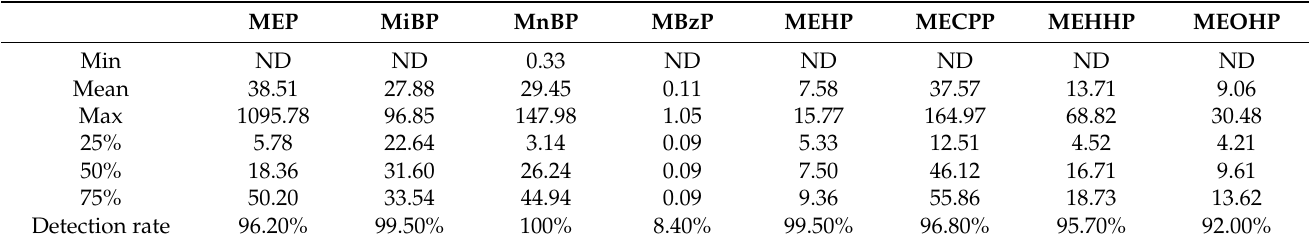
Table 2. Distribution of phthalate metabolite concentrations ( µ g/L) in urine samples for 294 children aged 4–8 years old in Tianjin, China.